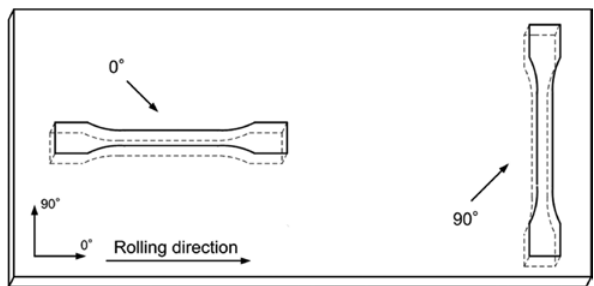
Figure 1: Angle between the specimens and the rolling